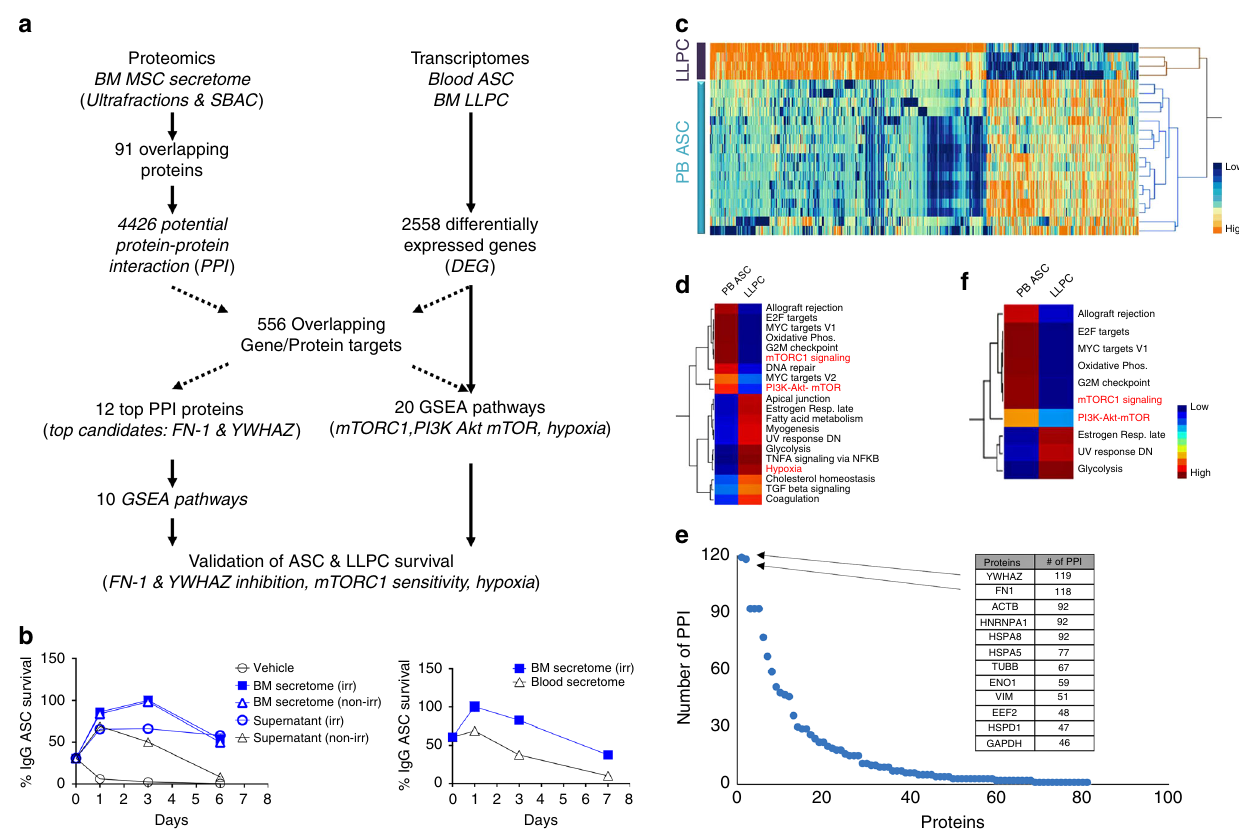
Fig. 4 Integrated bioinformatics of MSC secretome proteomics with transcriptomics of blood ASC and BM LLPC. a Flow diagram of the integrated bioinformatic analysis. b Proteomics of distinct MSC secretome fractions. Three fractions strongly support blood ASC survival (blue symbols): iMSC secretome (blue fi lled square; left and right panels), noniMSC secretome (blue open triangles; left panel), and supernatant fractionated by ultracentrifugation of iMSC secretome (blue open circles; left panel); and three fractions with decreased ASC survival (black symbols): conventional media (R10) (black open circles; left panel), supernatant fractionated by overnight ultracentrifugation of noniMSC secretome (black open triangles; left panel), and secretome from blood (not BM) adherent cells (black open triangles; right panel). c A heat map of the 2558 DEG between 17 blood ASC (PB ASC) obtained from seven healthy subjects and BM LLPC (LLPC) obtained from four adult subjects. d HIPPIE analysis of 91 MSC protein revealed 4429 potential protein partners (PPI). Overlap of the 4429 PPI with the 2558 DEG uncovered 556 overlapping gene/protein targets and led to 20 statistically signi fi cant GSEA hallmark pathways. e Of the aforementioned 91 MSC secretome proteins, FN-1 and YWHAZ had the highest number (118 and 119, respectively)